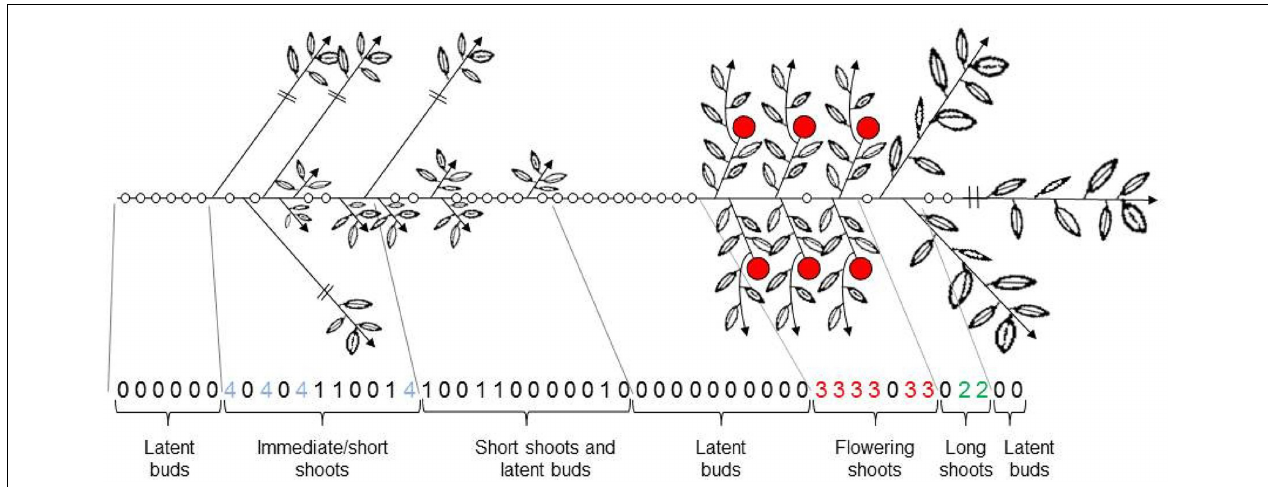
FIGURE 3 | Branching pattern along an apple long annual shoot. The segmentation of the parent shoot in branching zones with a distinct dominant axillary shoot type is indicated. 0 latent bud, 1 short proleptic shoot, 2 long proleptic shoot, 3 floral shoot, 4 sylleptic shoot (From Guédon et al., 2001).